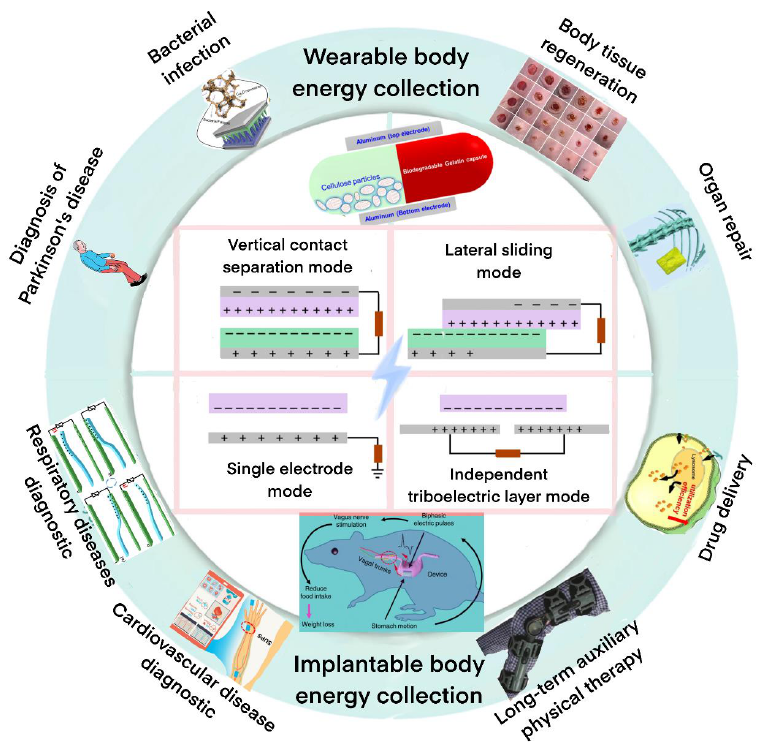
Figure 1. Triboelectric nanogenerators for long-term self-treatment and self-diagnosis.